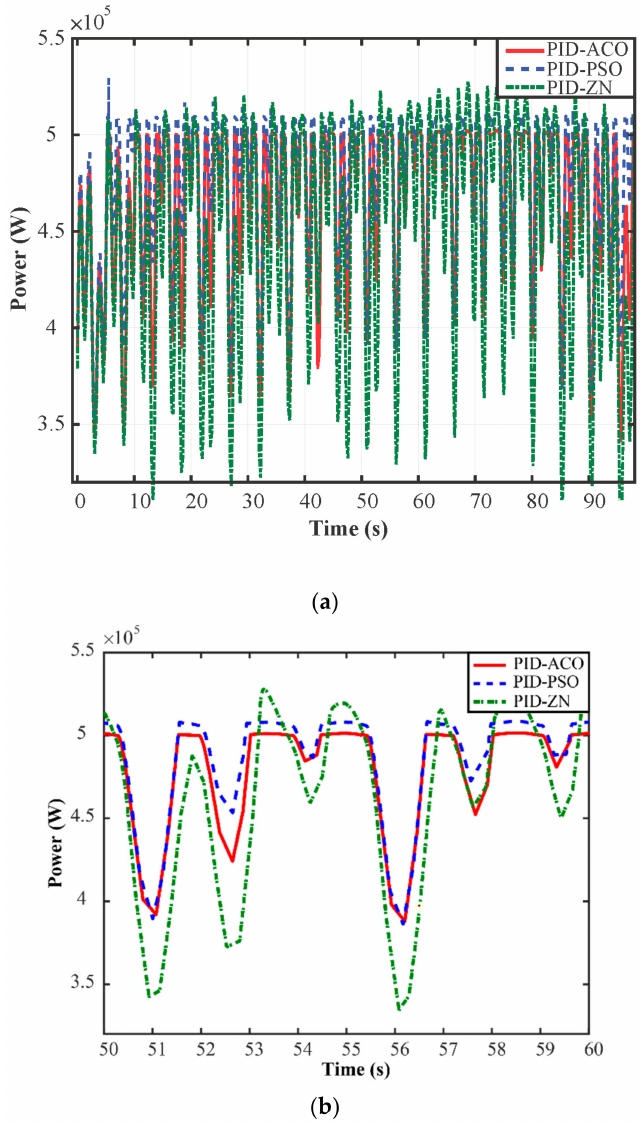
Figure 14. ( a ) Output wind power generation by the proposed controller; ( b ) Zoomed figure